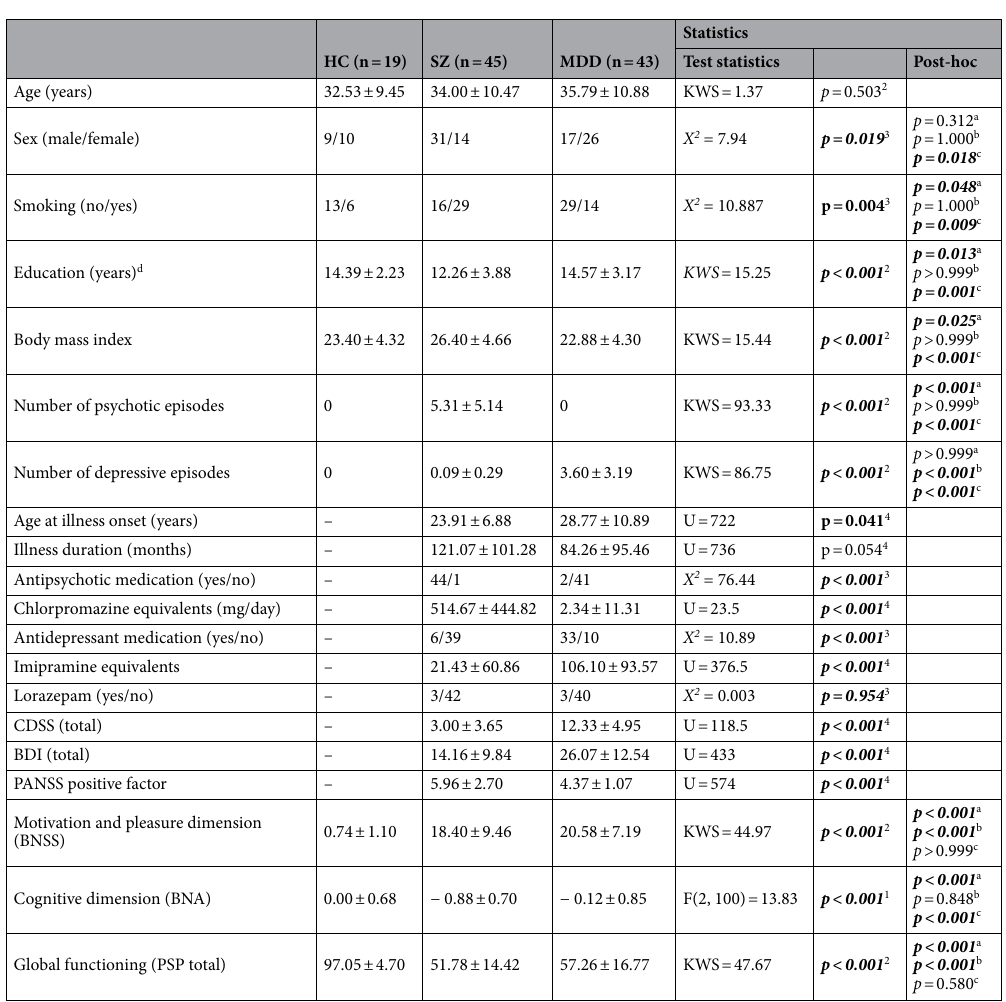
Table 1. Sociodemographic and clinical data. Statistics: 1 One-way analysis of variance (ANOVA), 2 Kruskal- Wallis test, 3 Chi-square test, 4 Mann-Whitney U test. Post-hoc. Tukey’s test for post-hoc comparisons of ANOVAs and Dunn’s test for post-hoc comparison of Kruskal–Wallis test: a HC vs. SZ, b HC vs. MDD, c SZ vs. MDD. BDI Beck Depression Inventory, BNA Brief Neurocognitive Assessment, BNSS Brief Negative Symptom Scale, CDSS Calgary Depression Scale for Schizophrenia, HC Healthy controls, MDD